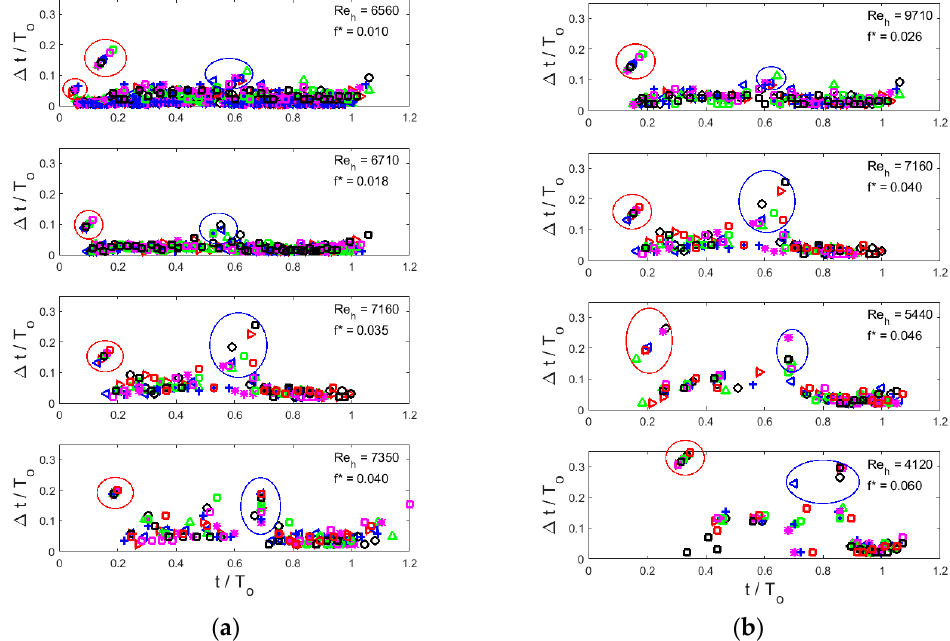
Figure 5. Vortex timing vs. cycle phase. ( a ) Constant u SS cases, with T o decreasing from top to bottom, resulting in nominally constant Reynolds number Re h , and increasing reduced frequency f* . ( b ) Constant T o cases, with u SS decreasing from top to bottom, resulting in decreasing Reynolds number Re h , and increasing reduced frequency f* . Note that the case Re h = 7160, f* = 0.040 appears in both columns. Each realization is indicated by different symbol, to highlight differences in vortex formation times between cycles. Data points inside red circles correspond to the first vortex (leading the jet), and points in blue circles indicate the first vortex after the mid-cycle calm interval.